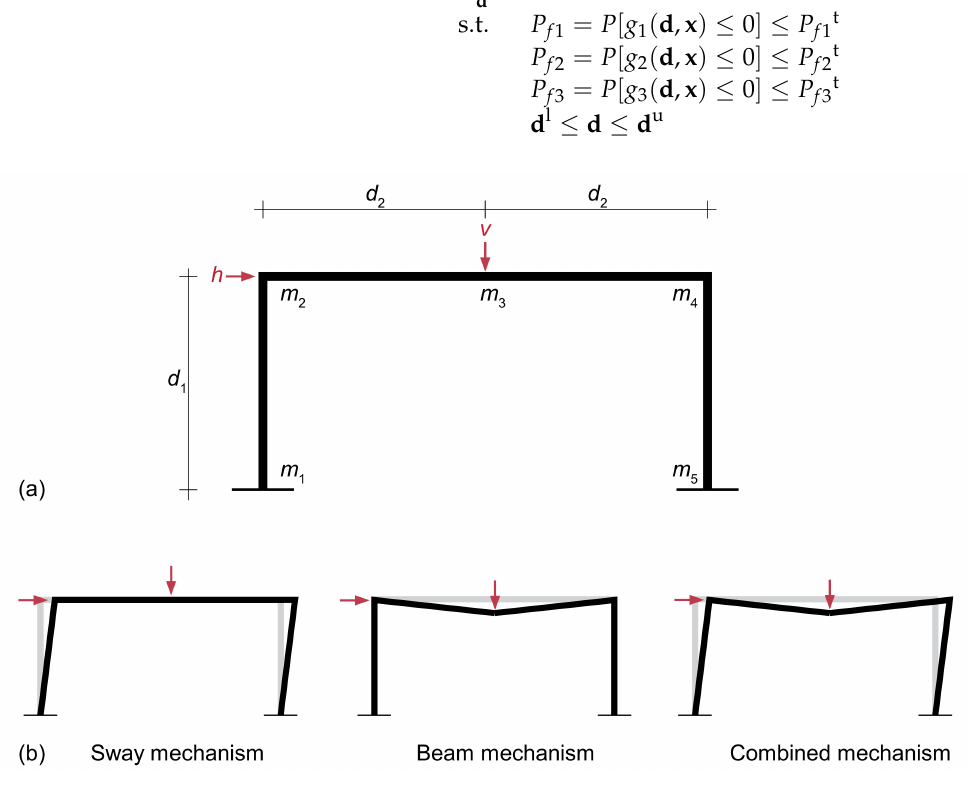
Figure 5. ( a ) Ductile frame structure, and ( b ) failure mechanisms. Table 4. Description of random variables for the ductile frame optimization